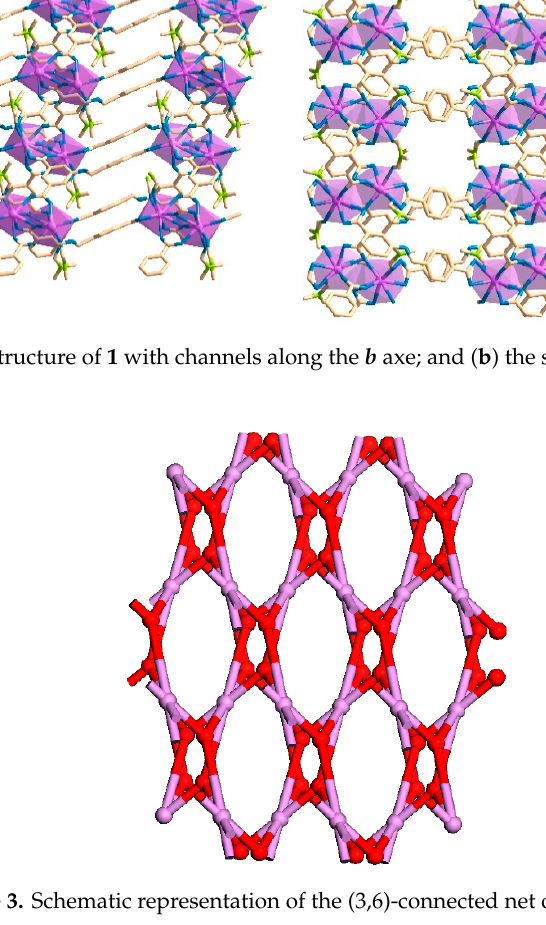
Figure 2. ( a ) The structure of 1 with channels along the b axe; and ( b ) the structure of 1 with channels along the c axe.